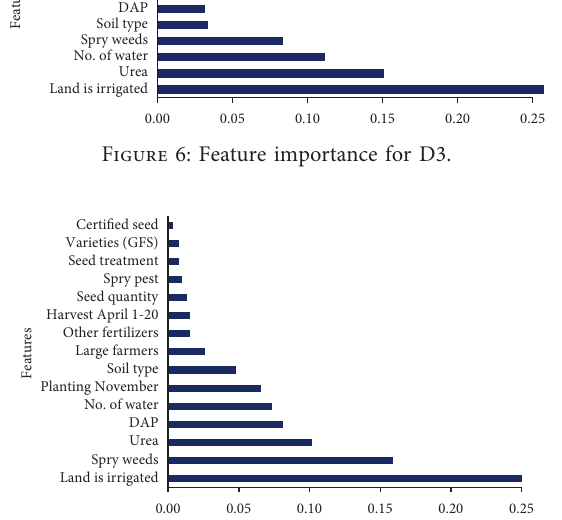
Figure 7: Feature importance for D4.